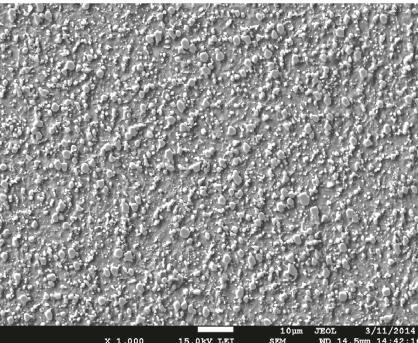
Figure 1: SEM micrograph showing the microstructure of the Vanadis 6 steel in as-delivered state.